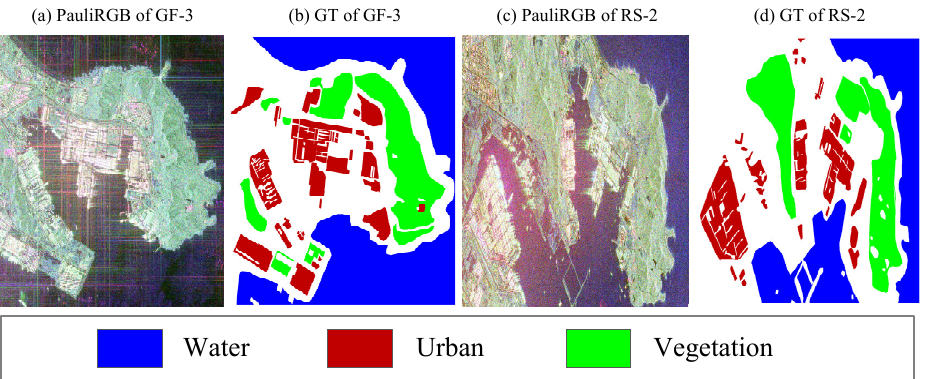
Figure 7. Pauli RGB and ground truth maps of the Qingdao datasets and the color code. ( a , b ) GF-3 Qingdao dataset. ( c , d ) RS-2 Qingdao